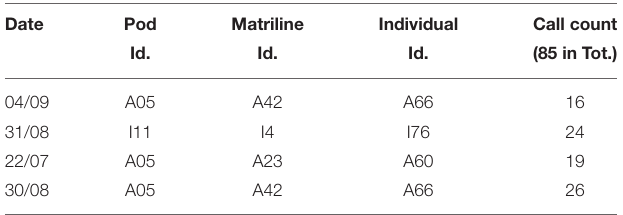
TABLE 3 | Summary of the three individuals for which we isolated calls.